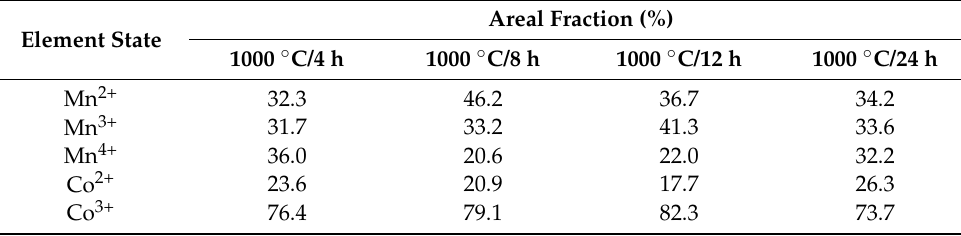
Table 3. Areal fractions of Mn and Co in the powders prepared under different